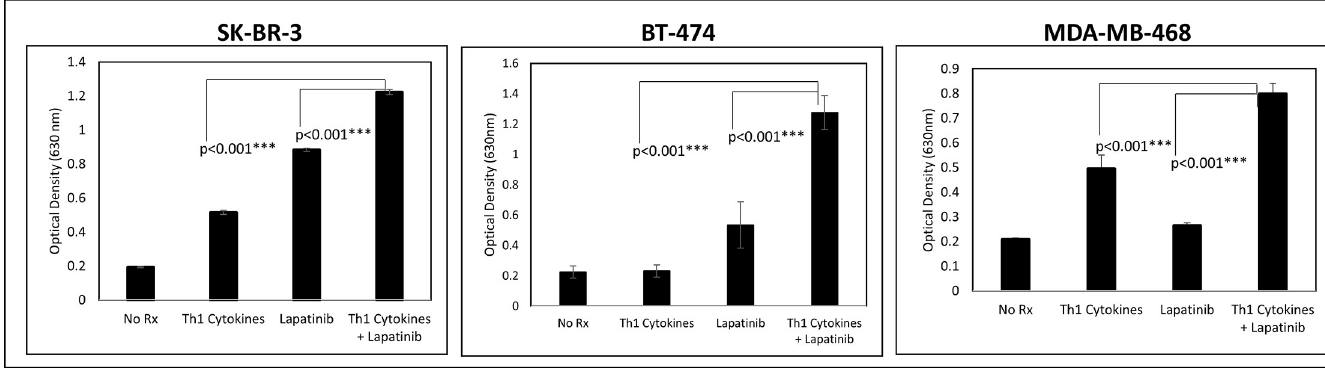
Fig 1. Lapatinib works in conjunction with Th1 cytokines to suppress metabolic activity of breast cancer cell lines. Cultured SK-BR-3, BT-474 and MDA-MB-468 cells were treated either with Th1 cytokines (TNF- α plus IFN- γ ; 20 and 12.5ng/ml respectively), Lapatinib (200nM), Lapatinib plus Th1 cytokines or left untreated (control). After 72 hours incubation, resazurin sodium salt was added to each well and further incubated until color change was noted, and optical densities of supernatants read spectrophotometrically at 630nM. Shown are composite data from at least three trials per cell line expressed as mean optical density +/- SEM. Statistical significance was determined by one-way ANOVA followed by the Holm-Sidak multiple comparison test. https://doi.org/10.1371/journal.pone.0210209.g001 PLOS ONE | https://doi.org/10.1371/journal.pone.0210209 January 18,